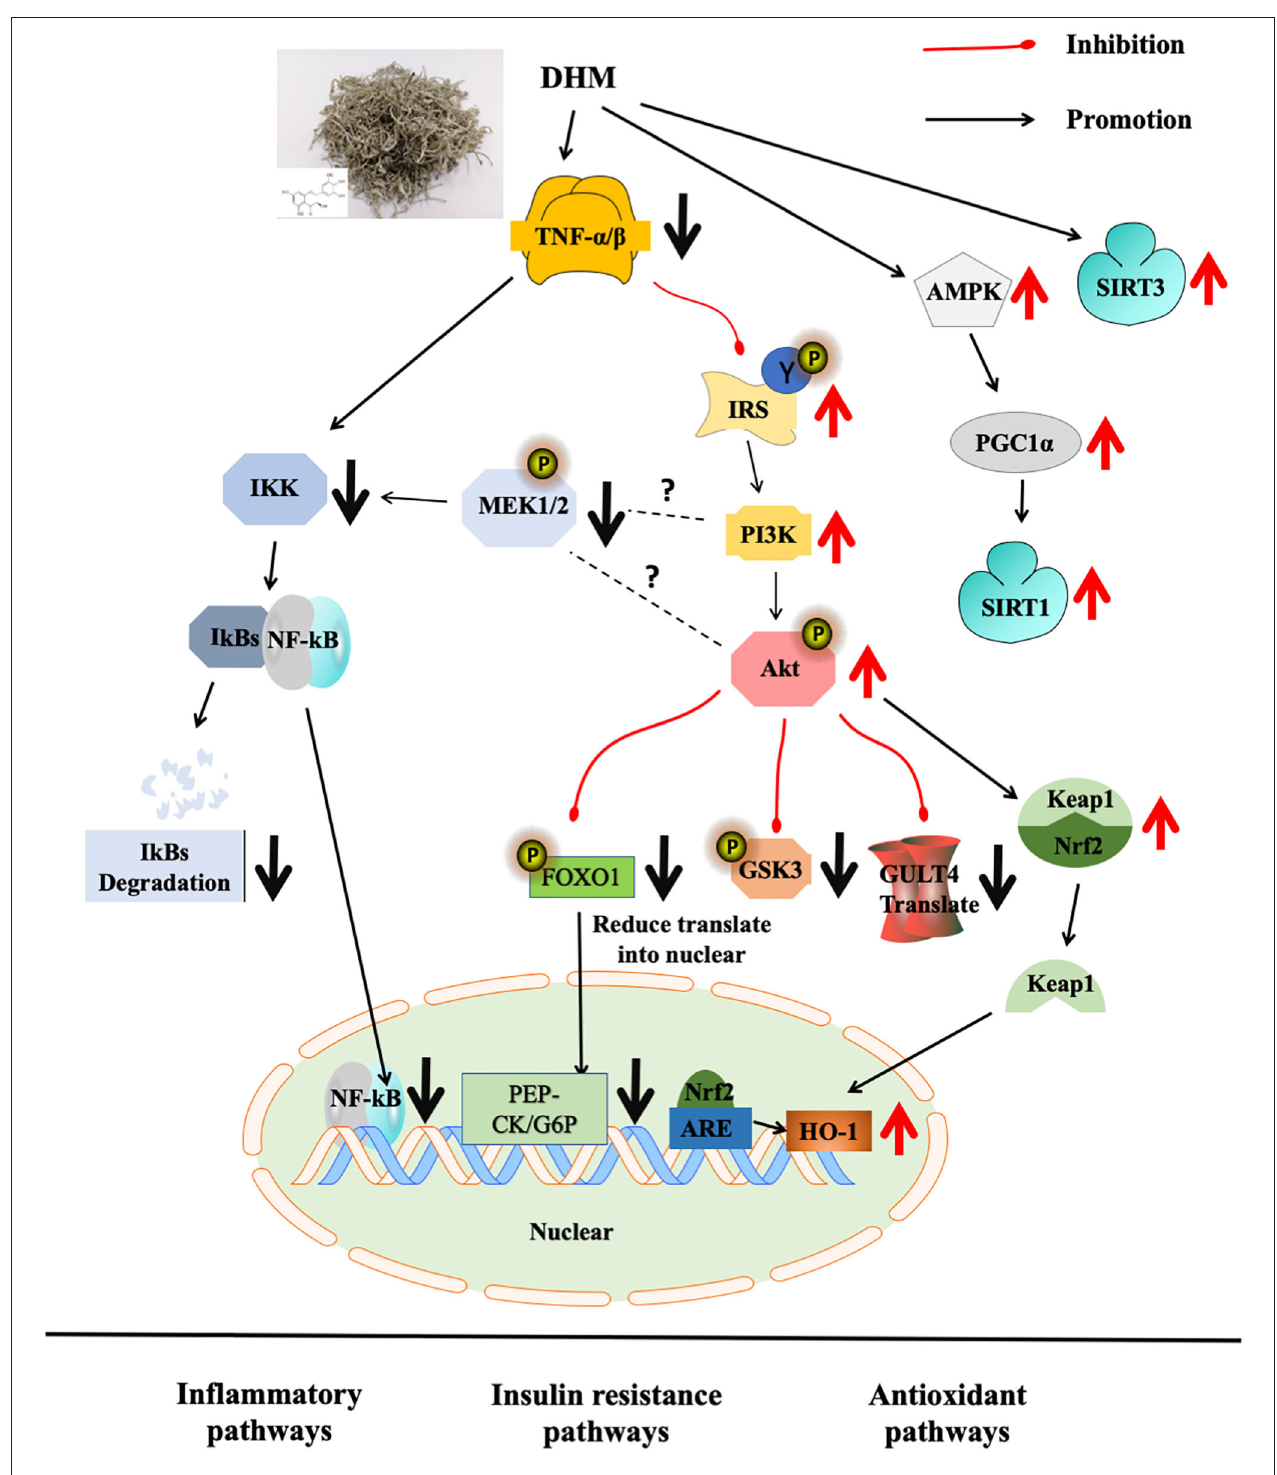
FIGURE 1 | Molecular mechanism of DHM on abnormal glucose and lipid metabolism.